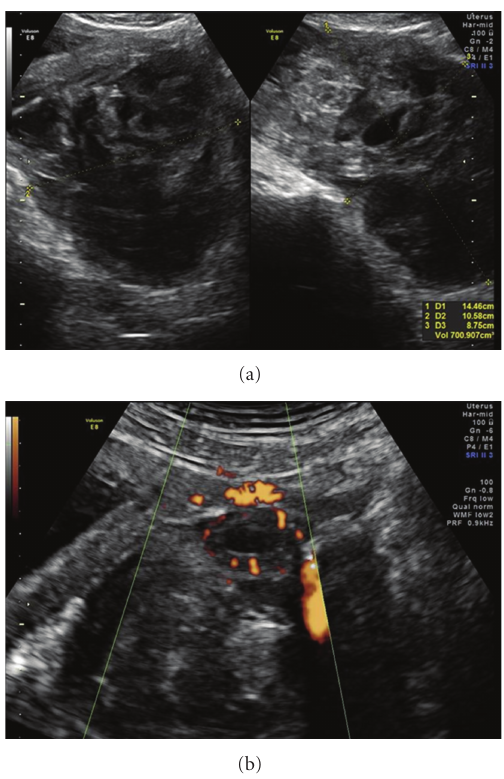
Figure 1: (a) B-mode endovaginal 2DUS showing a large irregular heterogeneous mass in the left pelvic abdominal region; (b) endovaginal 2DUS in power Doppler mode showing “ring” vascu- larization, indicative of a gestational sac. 2DUS: two-dimensional ultrasound.